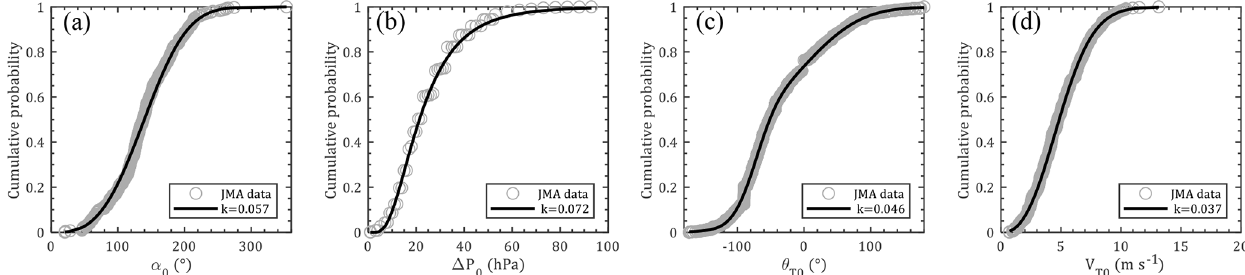
Figure 4. CDFs of track genesis parameters: (a) α 0 ; (b) (cid:49)P 0 ; (c) θ T0 ; (d) V T0